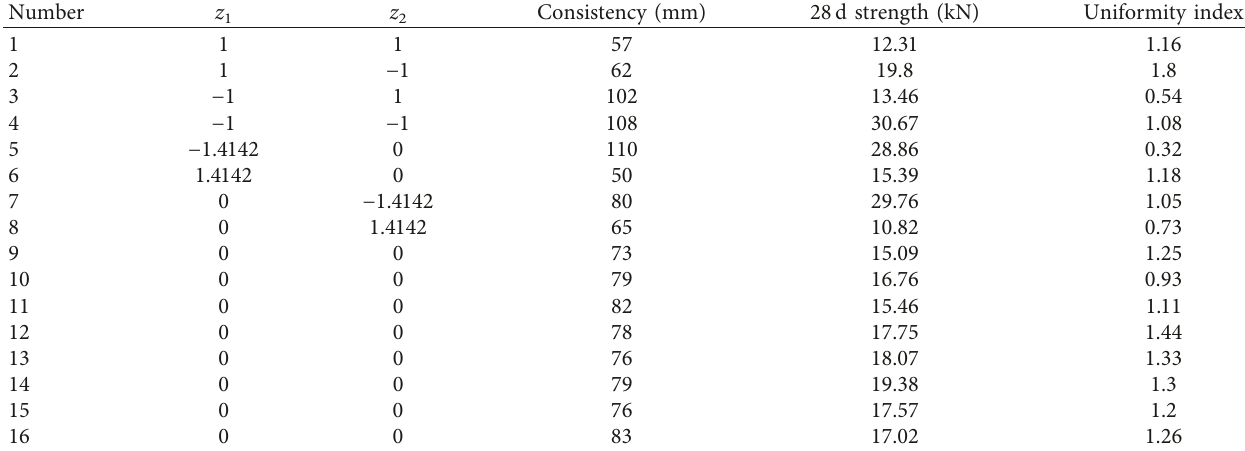
Table 7: Designed experimental data of binary quadratic orthogonal rotation combination.